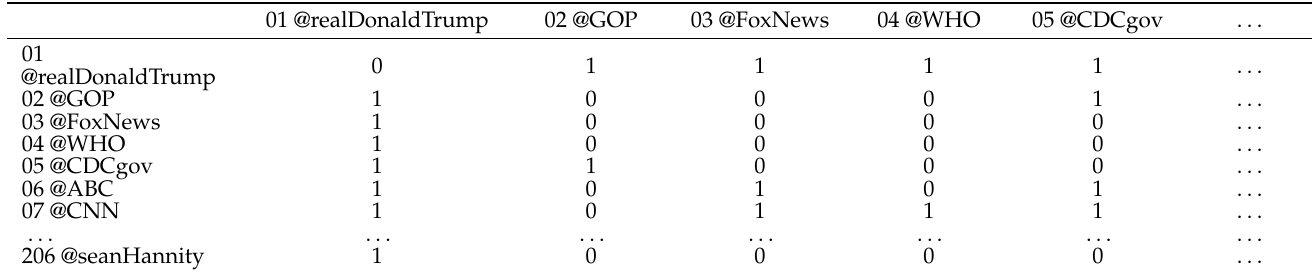
Table 2. Relationship matrix of key influencer accounts (206 for Twitter and 183 for Weibo).